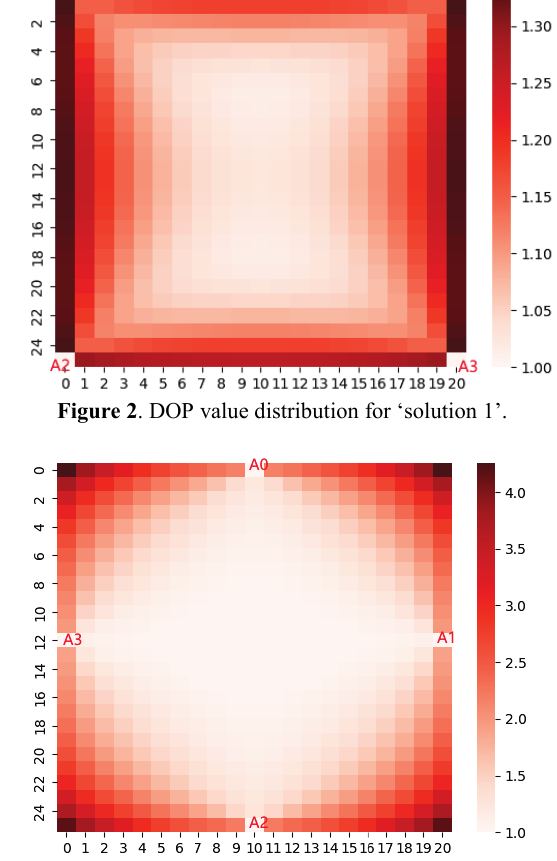
Figure 3 . DOP value distribution for ‘solution 2’.